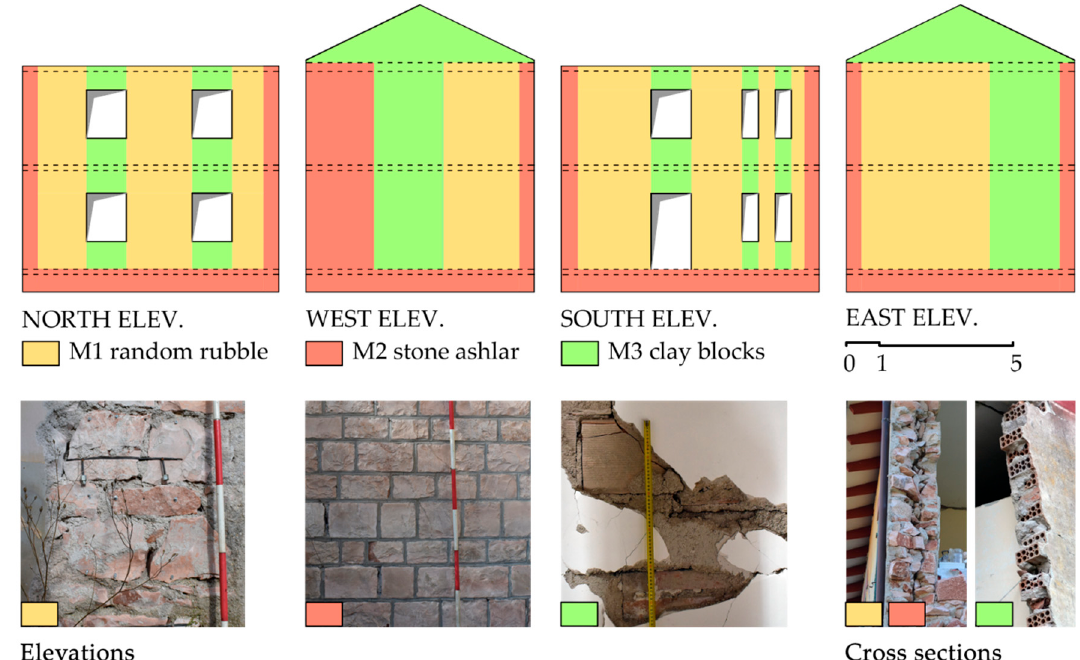
Figure 5. Distribution of masonry types within IACP building.